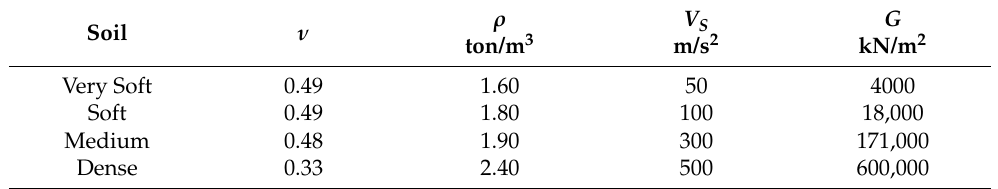
Table 1. Soil properties.